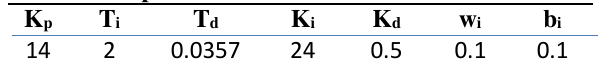
Fig. 9. Matlab simulink connection for the robotic leg with the suggested hybrid controller; (a): complete connection; (b): neural network connection; (c): nonlinear leg model connection The controller's parameters are given by Table 2. Controller